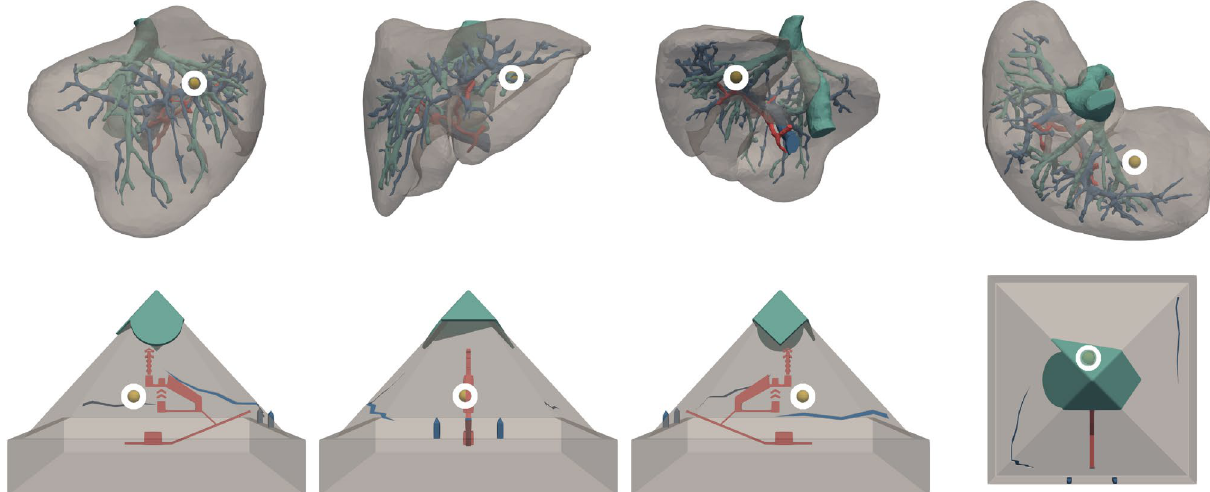
− − x, z. (Top) Liver: portal vein